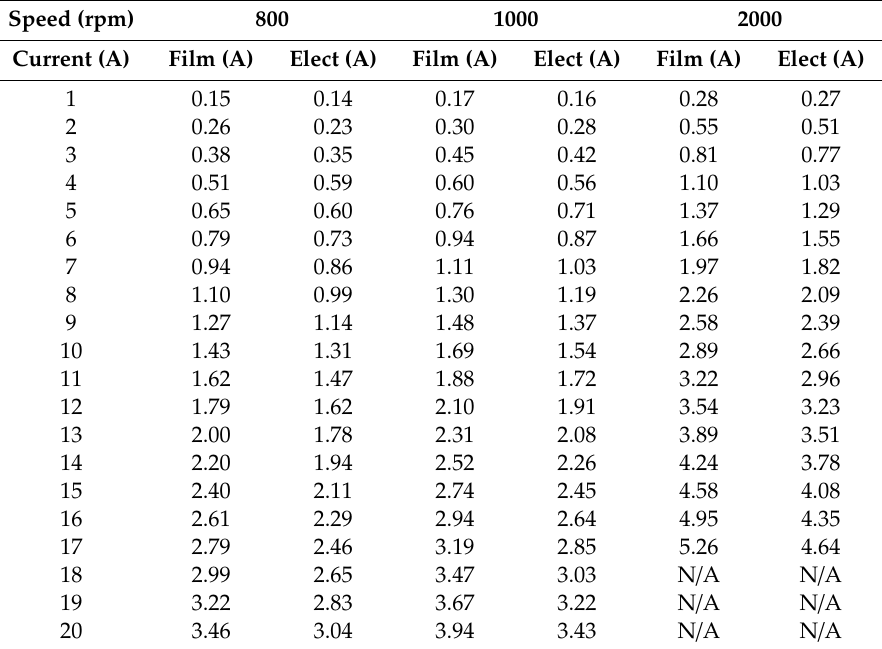
Table 4. Capacitor RMS current at a speed range of 800–2000